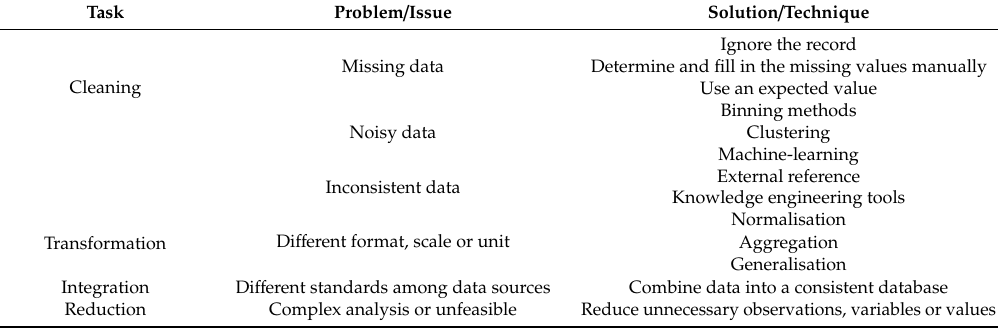
Table 2. Data pre-processing: The tasks perform in data pre-processing include their common problems and solutions of these problems